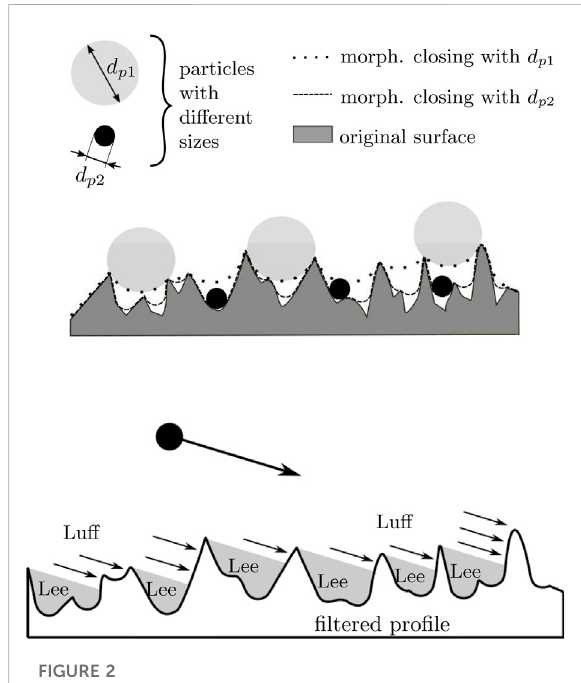
FIGURE 2 Local impact angle: (A) morphological fi lter with respect to the particle size; (B) particle impact on the luff sides of the surface roughness for oblique impacts (Altmeppen et al.,